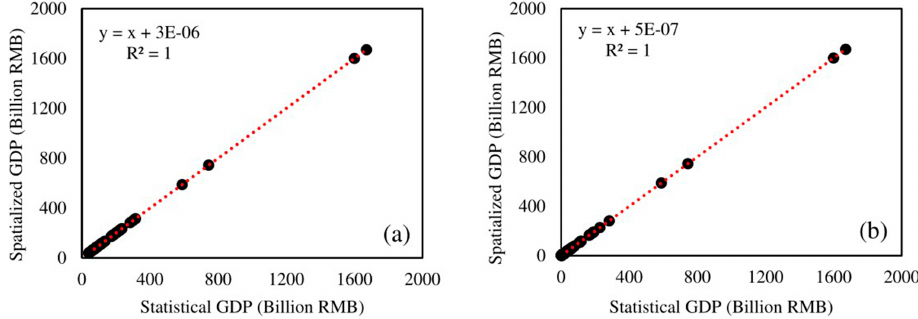
Figure 11. Relationships between statistical GDP and spatialized GDP from the corrected VIIRS data at: ( a ) prefecture level; and ( b ) county level.